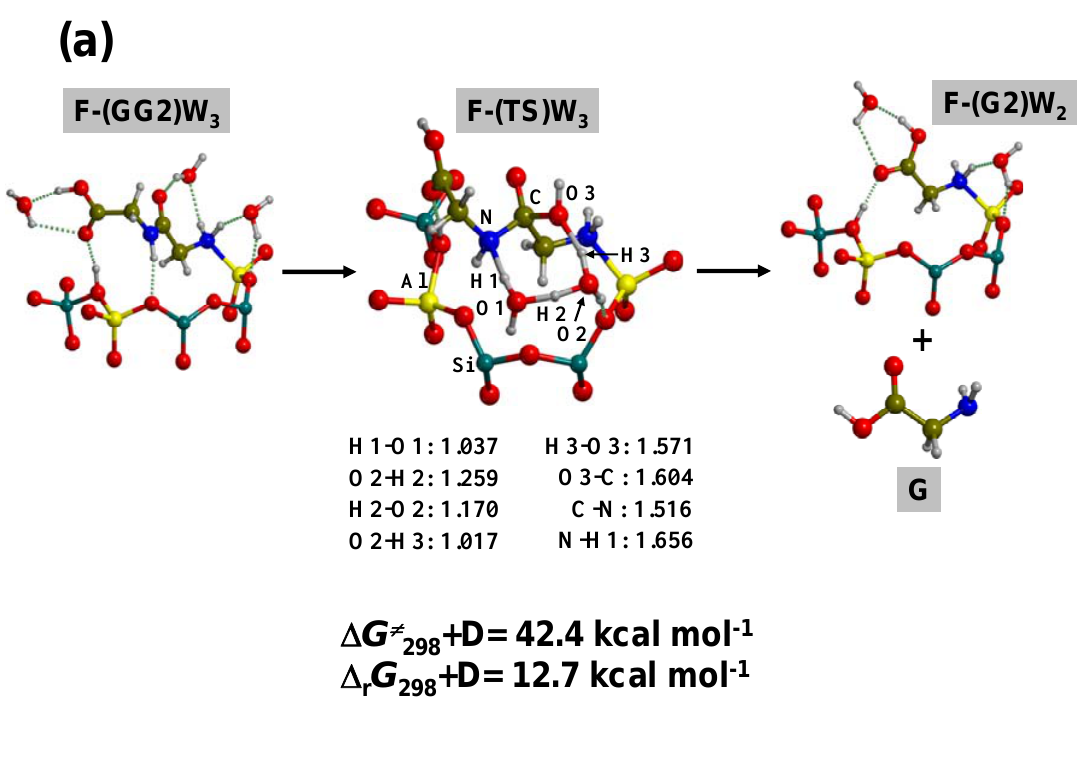
as a reference state. (b) Displacement 3 O molecules. F-GGG2 + W 2